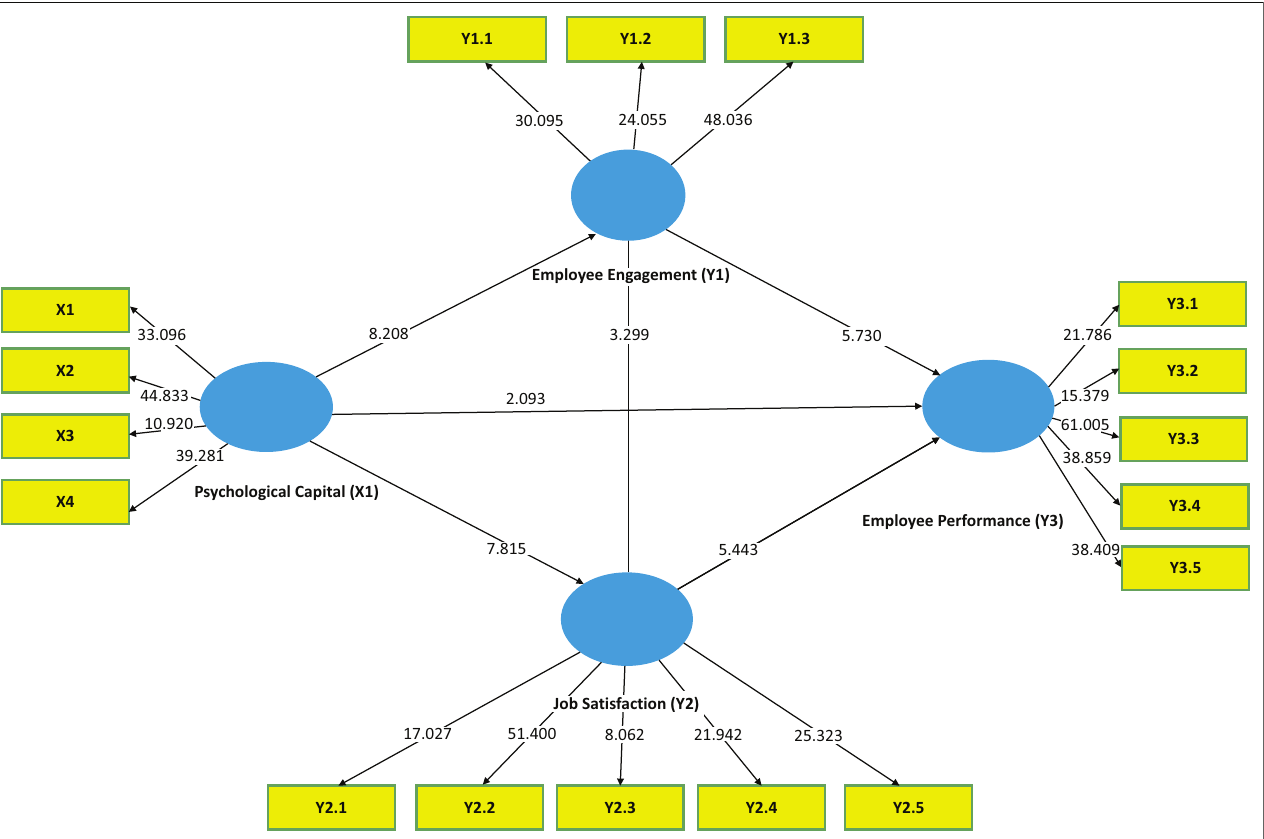
FIGURE 10: Measurement